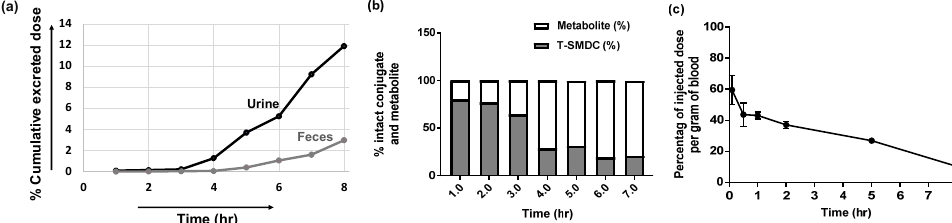
Figure 3. ( a ) Time-dependent clearance of [ 18 F]F-TZ(PSMA)-LEGU-TLR7 from the body measured by cumulative radioactivity found in the urine and feces in terms of percentage of the injected dose (%ID) ( n = 5). ( b ) Metabolites and intact [ 18 F]F-TZ(PSMA)-LEGU-TLR7 found in the urine. Data presented as area under the curve in radio TLC. ( c ) Time-activity-curve (TAC) in the blood after intravenous injection of [ 18 F]F-TZ(PSMA)-LEGU-TLR7 into mice ( n = 3 in each time point); data presented as average %ID/g ± s.d. ( n = 3).